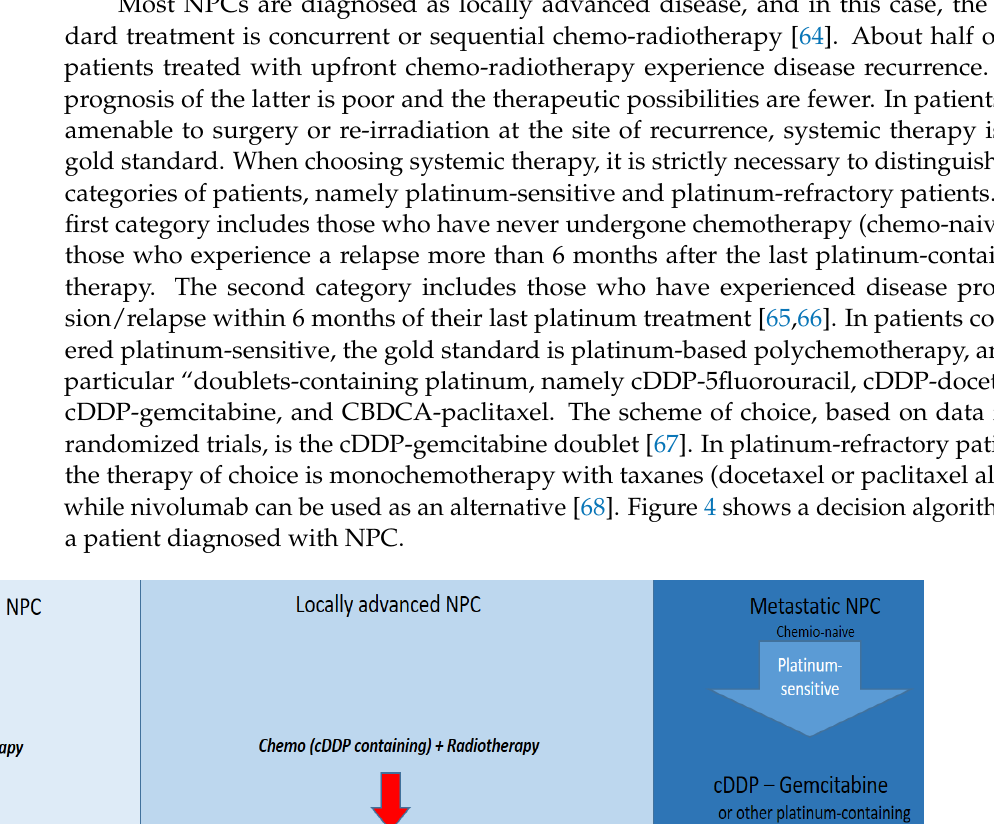
Table 1. Clinical trials with check-point inhibitors enrolling patients with recurrent/metastatic NPC.